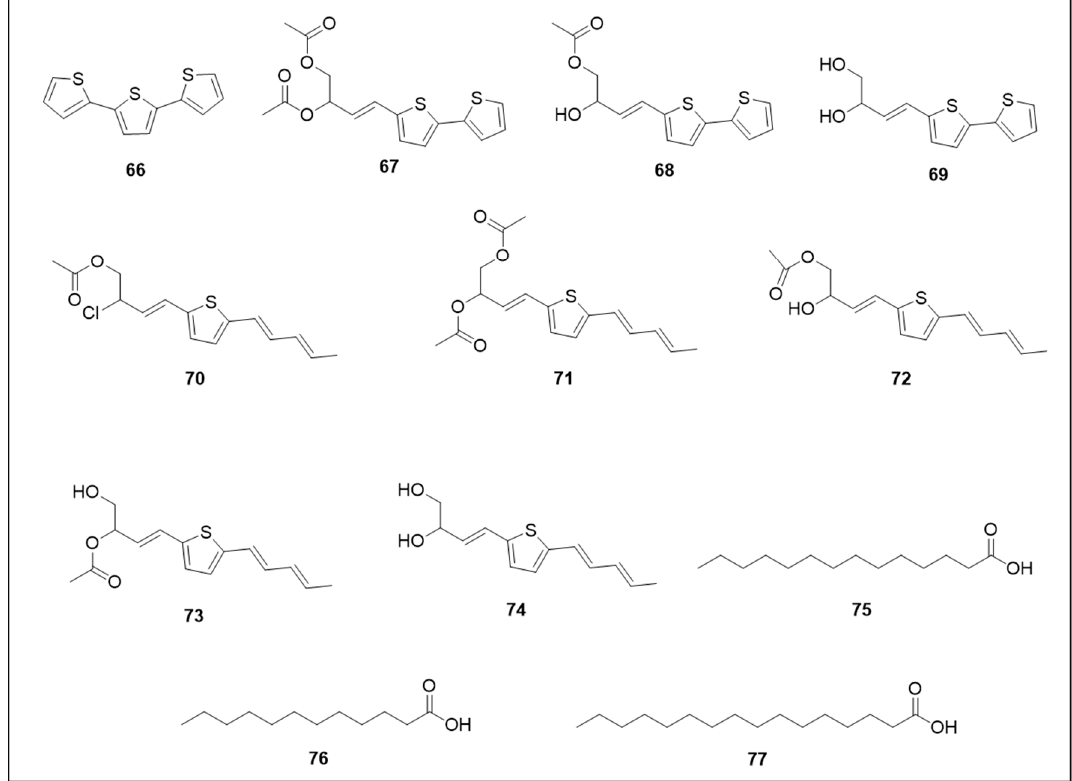
Figure 10. Fatty acids and thiophene derivatives active against Ae. aegypti .